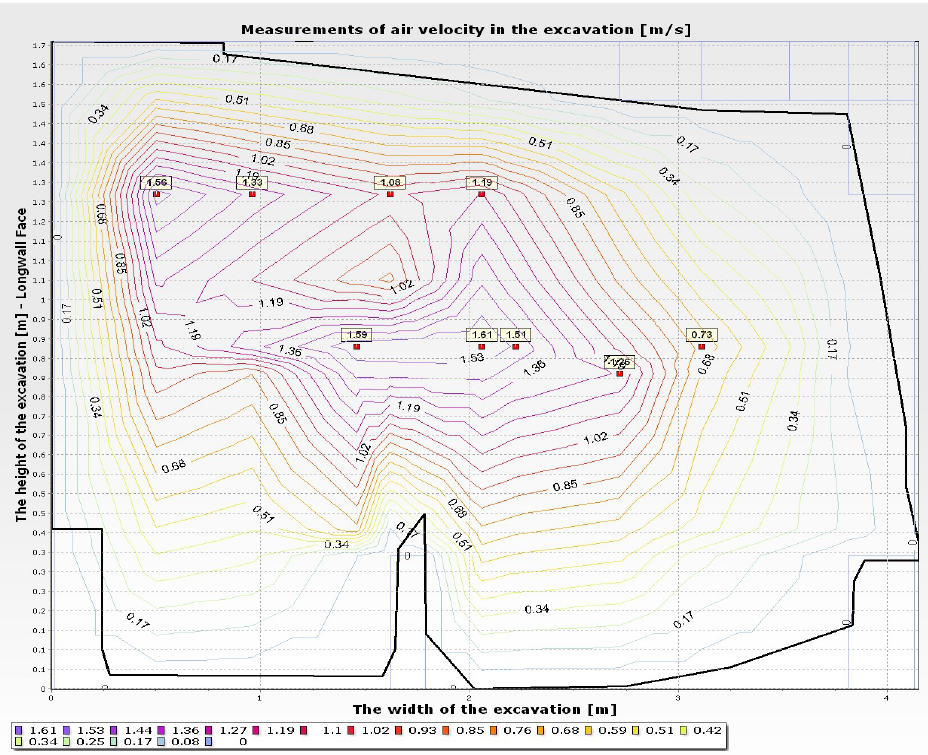
Figure 11. Velocity profile in the Cw-4 longwall cross-section at 8:00.